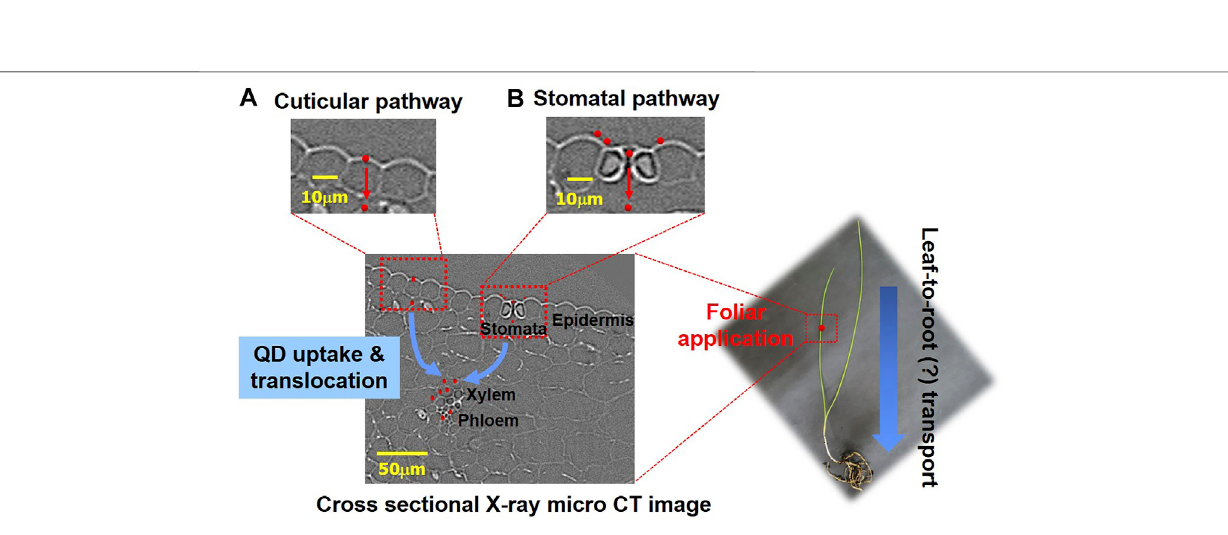
Frontiers in Environmental Science |